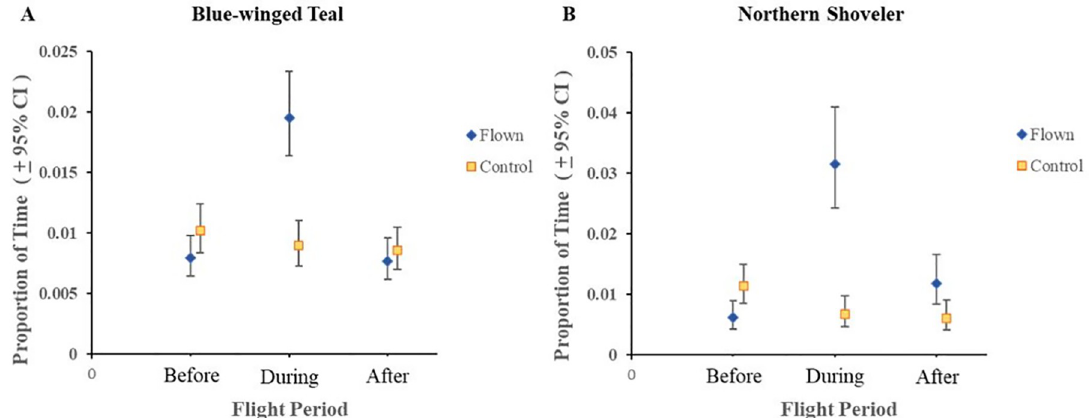
Fig 3. Least square means and 95% confidence intervals of proportion of time spent on overhead vigilance behavior for blue-winged teal (A) and northern shoveler (B) within treatments groups (Flown vs. Control). This behavior consisted of the ducks tilting their head to look at the UAV above them.